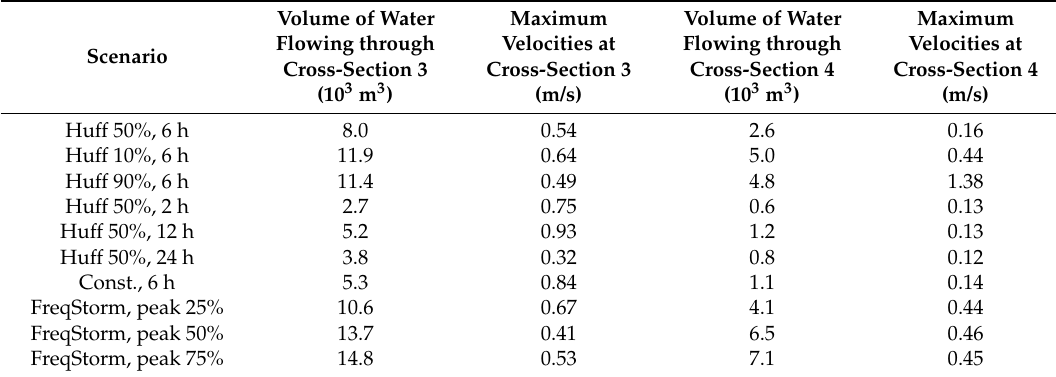
Table 7. Comparison among maximum floodplain velocities and floodplain volumes (cross-sections 3 and 4) for different scenarios for the 100-year return period. Bold values indicate the maximum values in each column.